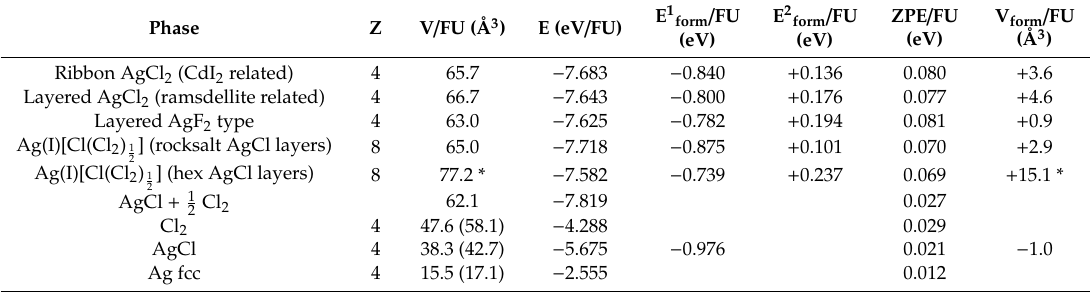
Table 1. Calculated DFT + U volumes and energies including van der Waals correction (E), zero-point energies (ZPE) and formation energies calculated in respect to the elemental crystals (E 1 form = E − E 1 Cl 2 (E 2 form = E − E ) for five prototypical AgCl 2 Ag + Cl2 ) as well as to AgCl and AgCl + 1 2 Cl2 2 polymorphs. The formation energies are calculated considering high-temperature crystal structure of Cl 2 [43]. Volume values in brackets come from experiment. The formation energy for AgCl is calculated as E form = E − E . FU = formula Ag + 1 2 Cl2